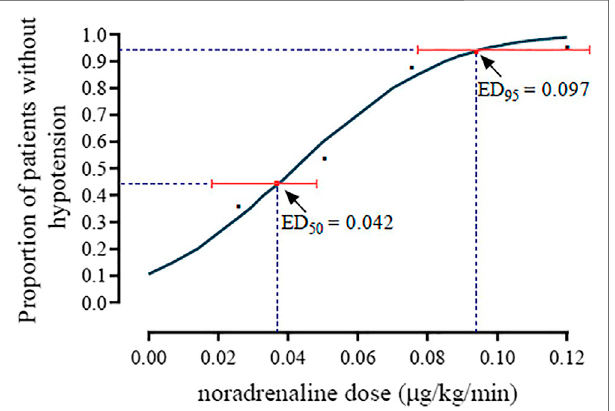
1,584 ± 31, 1,653 ± 25, and 1,464 ± 36 min × mm Hg in groups 0, 0.025, 0.05, 0.075 and 0.1 μ g/kg/min, respectively, and there was a signi fi cant linear trend across groups ( p < 0.001). The timing and incidence of hypotension in the fi ve groups using Kaplan-Meier curves are shown in Figure 4 . The log-rank test showed a signi fi cant difference among groups ( p < 0.001).